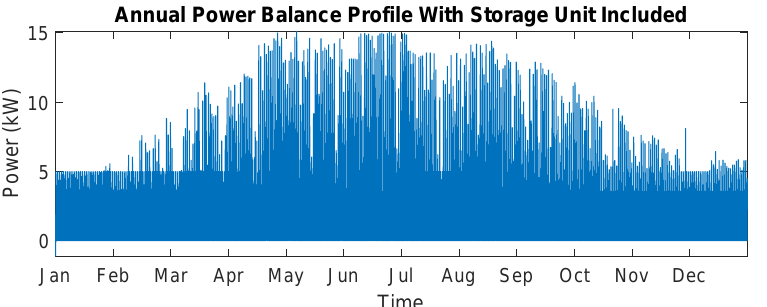
State-of-charge Profile (Daily Excerpt) Figure 7. Annual state-of-charge profile of the storage unit when considering the previously stated design